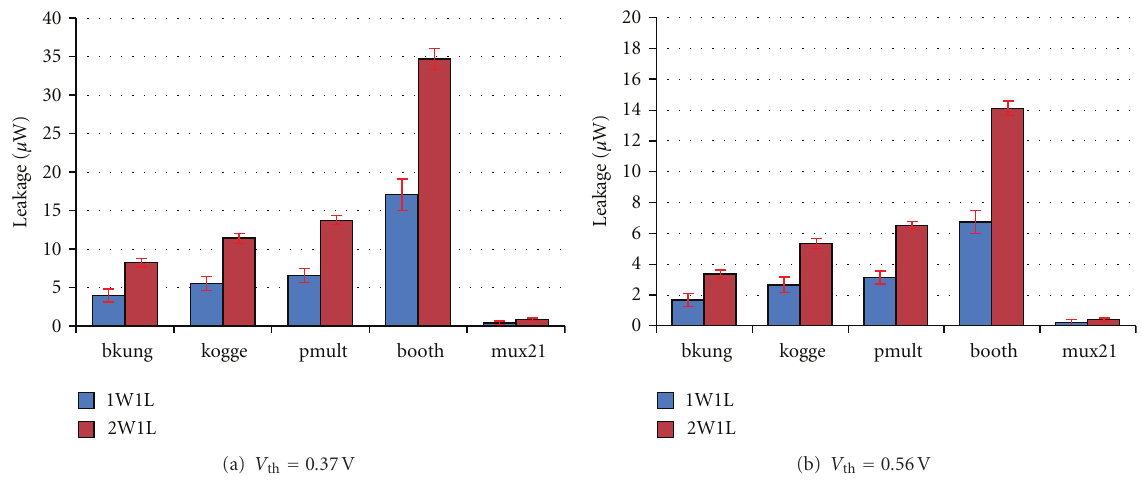
Figure 9: Leakage power characterization of function units with multi- V th /V dd and variation awareness.